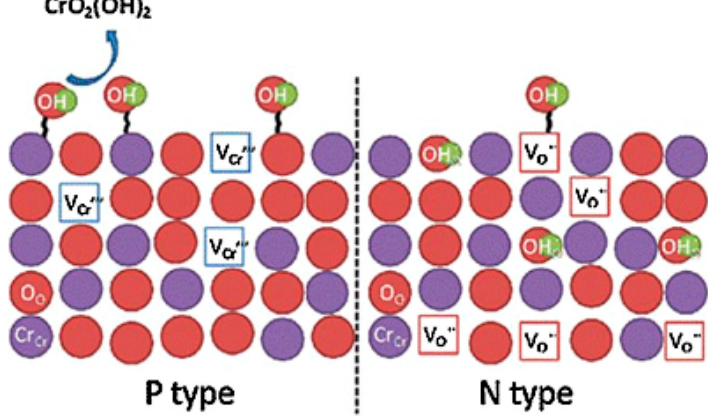
Figure 9. Comparison of defect structures of p-type and n-type chromia with regards to surface adherence of OH − groups, adapted from [45], with permission from Elsevier, 2018.